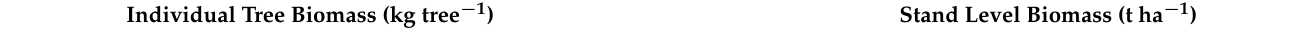
Table 2. Effect of initial planting density on individual tree and stand level biomass production of Chinese fir; where D1, D2 and D3 are low, intermediate and high density stands. Values are mean ± SE, and means followed by different letter(s) across the row are significantly different ( p < 0.05). Tree